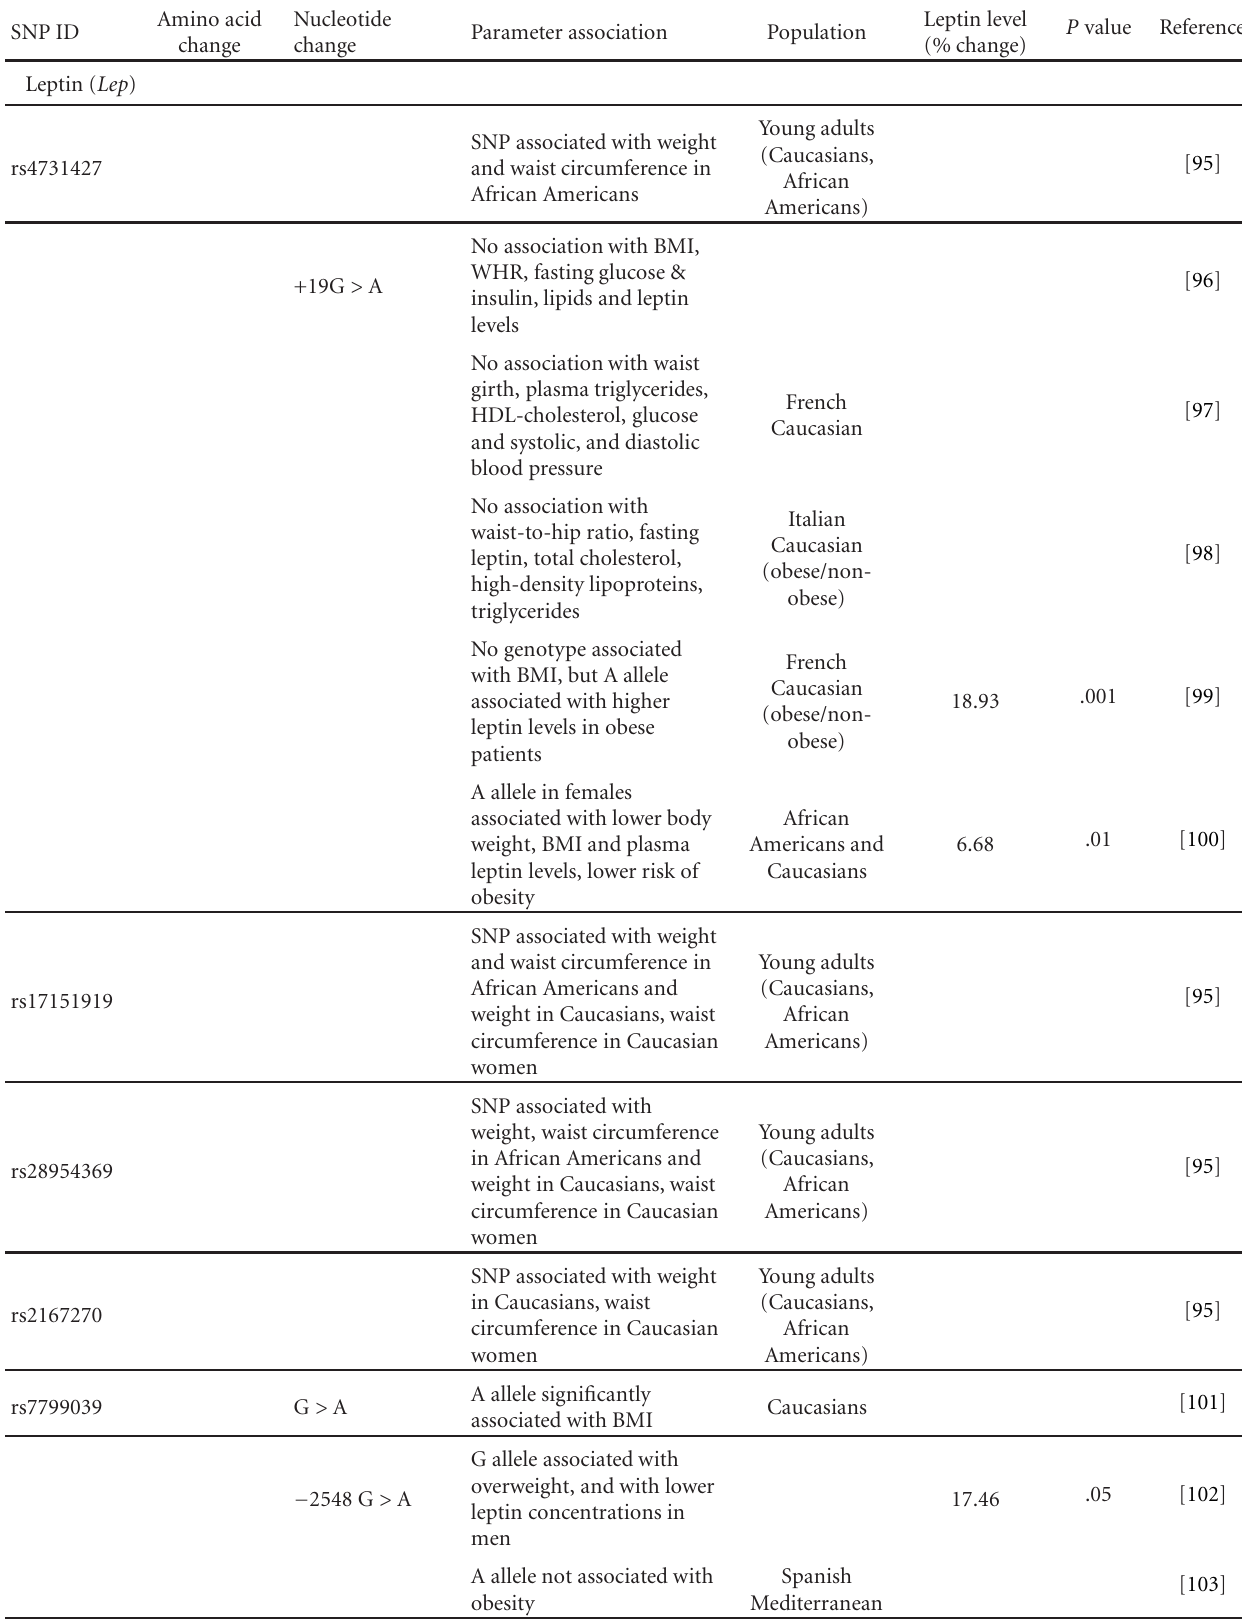
Table 2: SNPs in the Leptin ( Lep ) and Leptin Receptor ( LepR )